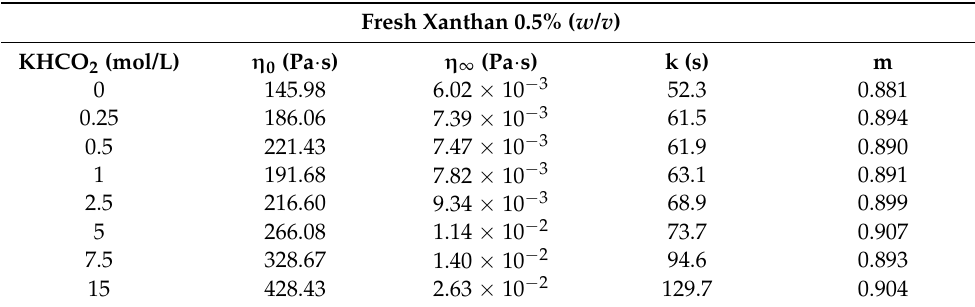
Table 1. Cross model parameters for fresh samples XG 0.5% ( w/v ) as a function of the formate